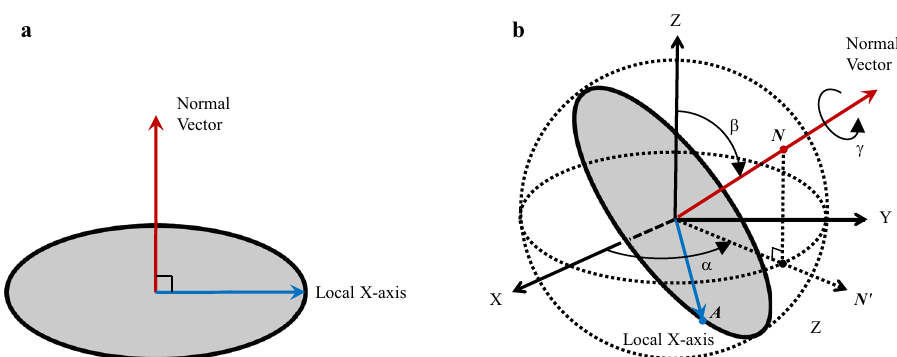
Fig. 1 The orientation of a projection image can be represented by its normal vector and its local X-axis vector which are perpendicular to each other. a The projection image in its local coordinate system. b The projection image in the 3D reconstruction space, where the normal vector can be represented by its intersection point N on the unit spherical surface, and the local X-axis vector can be represented by its intersection point A on the unit spherical surface. The Euler angle β is the angle between the Z-axis and the normal vector, the Euler angle α is the angle between the X-axis and N ′ vector which is the projection of the normal vector on the X – Y plane, and the Euler angle γ is determined by the in-plane rotation of the local X-axis vector along the